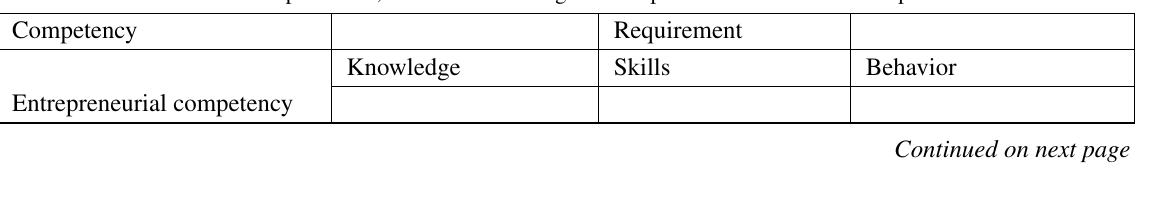
Table 2. Entrepreneurial,technical and managerial competencies for a